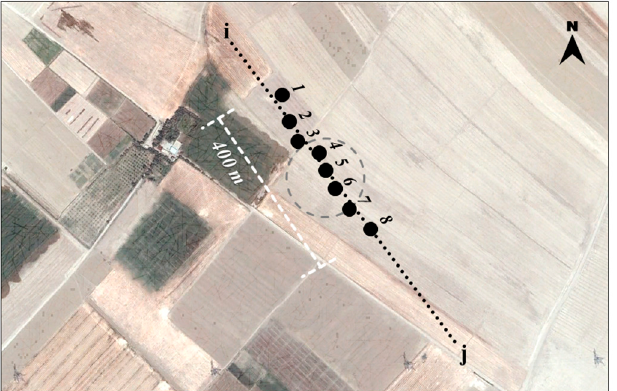
Figure 6. PSs inside and outside of the cave area shown by black circles (the cave boundary is marked by a dashed circle), and the dashed line (ij) indicates the profile of one kilometer over the cave